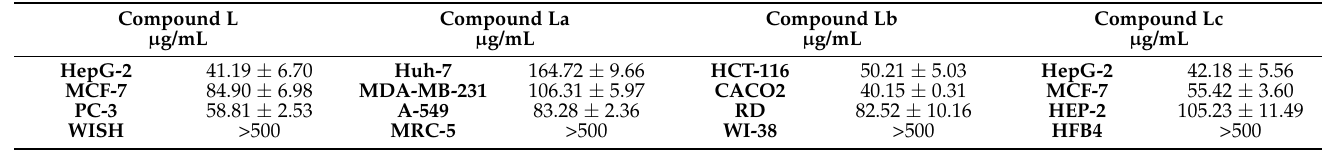
Table 5. The inhibitory effects (IC 50 %) of the Schiff base compound and its complexes against different types of cell